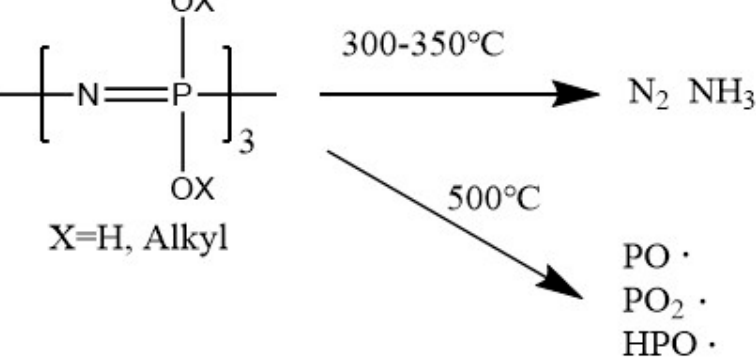
Figure 9. Effect of phosphazene weight fraction on the char yield for epoxy/phosphazene compo- sites, in nitrogen ( ● ) and air ( ▲ ) atmosphere [133].